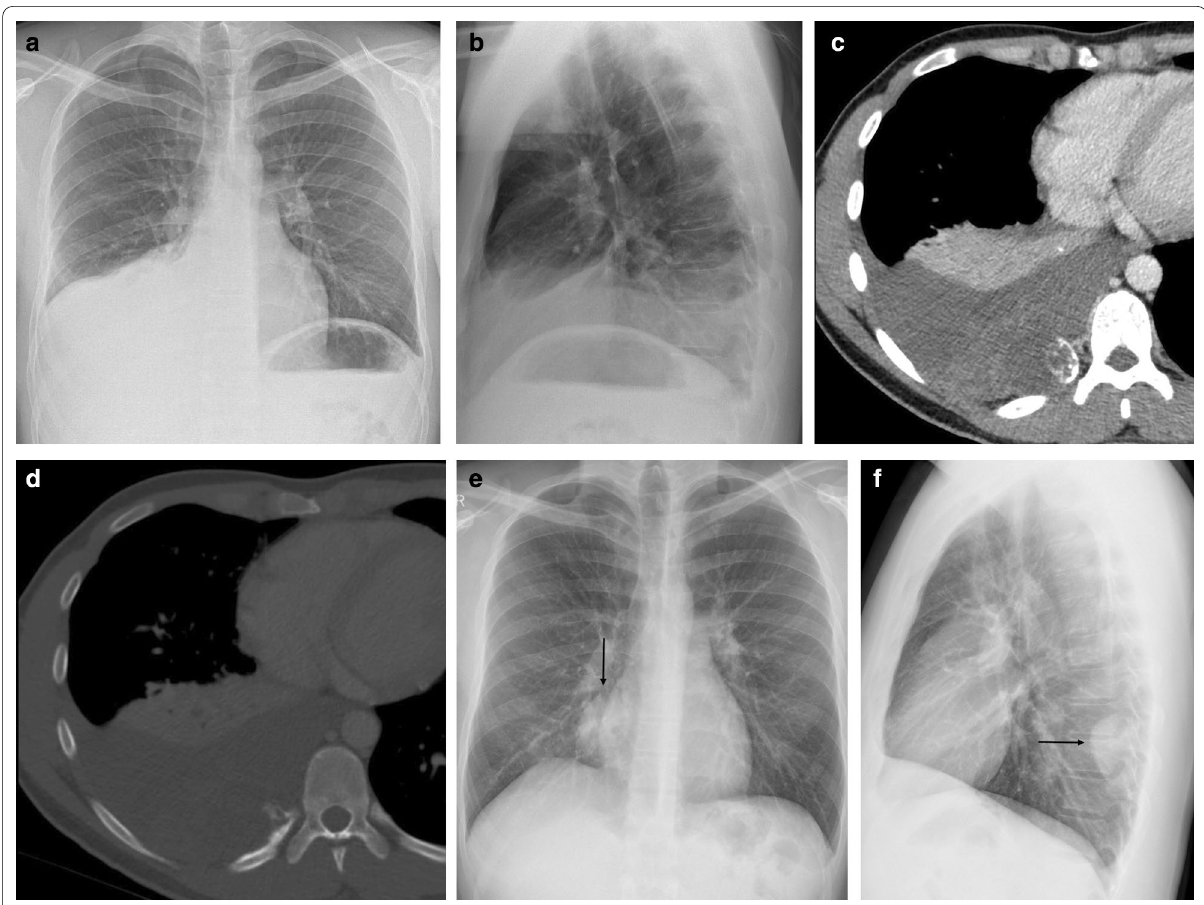
Fig. 10 Diagnosis: chondrosarcoma. Technique: standard chest radiography and contrast-enhanced chest CT. Description: A 25-year-old male presented with progressive worsening, inspiration-bound thoracic pain. Postero-anterior and lateral chest radiographs ( a , b ), which were performed to rule out a spontaneous pneumothorax, show a unilateral right-sided pleural effusion. Further diagnostic work-up with CT was performed. Axial contrast-enhanced CT ( c ) shows a massive pleural effusion masking a heterogeneous tumoral mass arising from the posterior side of the 10th rib with arc-and-ring calcifications. The locoregional bone destruction is best seen in the bone window ( d ). The postero-anterior and lateral chest radiographs after drainage of the pleural fluid ( e , f ) reveal the nodular mass (arrow) projecting into the right paravertebral on the PA image and posterior in the right lower lobe on the lateral chest radiograph. These imaging characteristics were suggestive of a chondrosarcoma, which was histopathologically confirmed after surgical